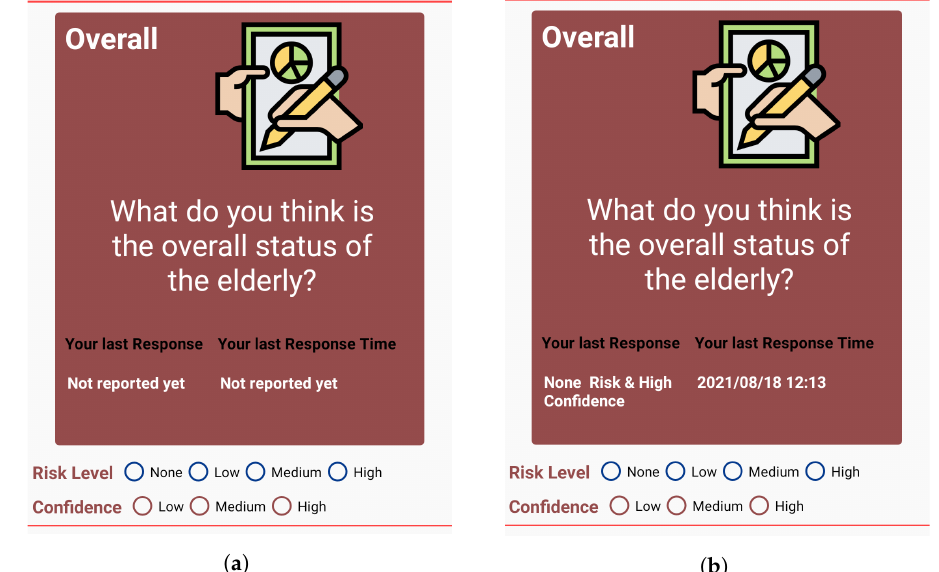
Figure 5. Overall report card: ( a ) before report submission and ( b ) after report submission.